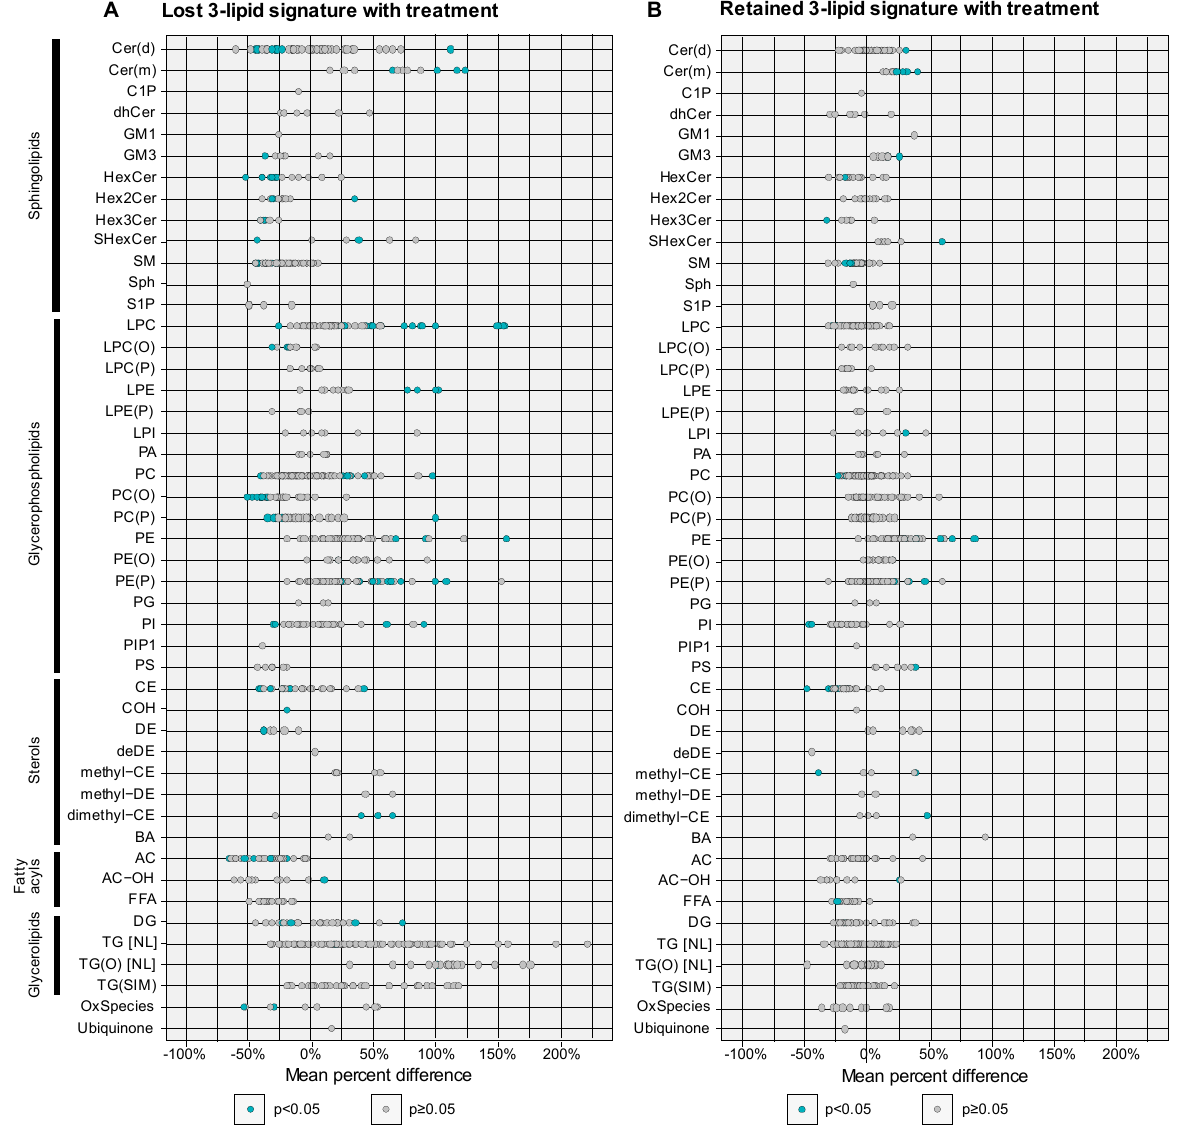
Figure 4. Mean percent difference of plasma levels of individual lipid species, grouped by lipid class, in post-simvastatin profiles vs. baseline from ( A ) men who lose the 3-lipid signature with treatment; and ( B ) men who keep the 3-lipid signature with treatment. Each datapoint represents a lipid species within the lipid class. Blue datapoints indicate statistically significant differences with p -value < 0.05 by paired t-tests.